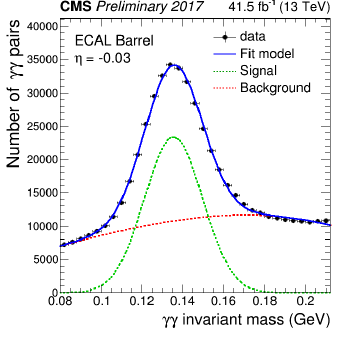
Figure 2. Reconstructed invariant mass distribution of photon pairs around the π 0 mass peak for one barrel crystal in